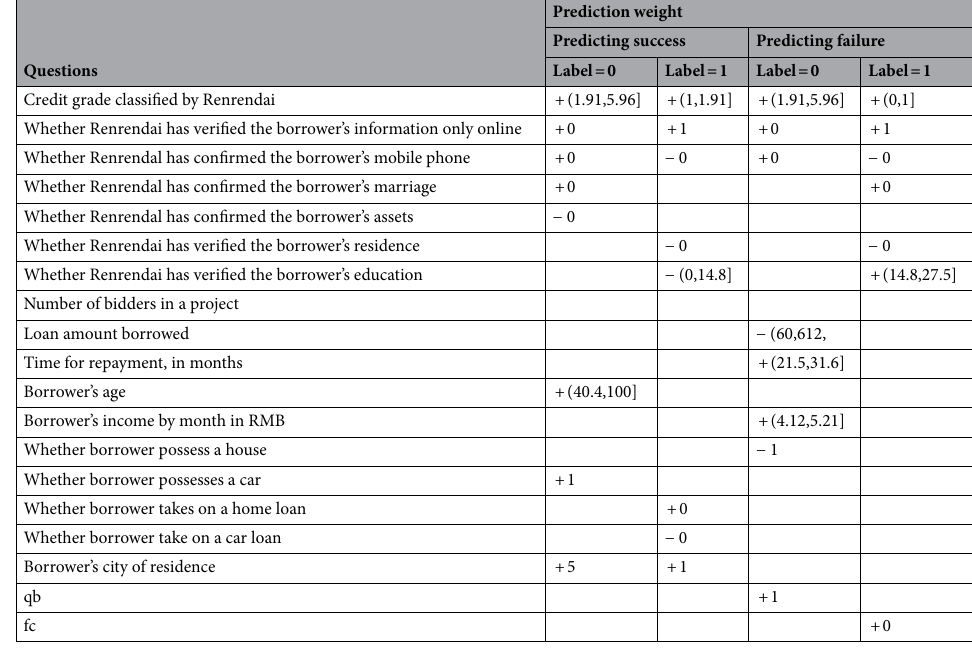
Table 3. Variable weights of the GBM model. Label = 0 means Repayments Success. Label = 1 means Repayments Failure. ‘+’ means Supports, ‘−’ means